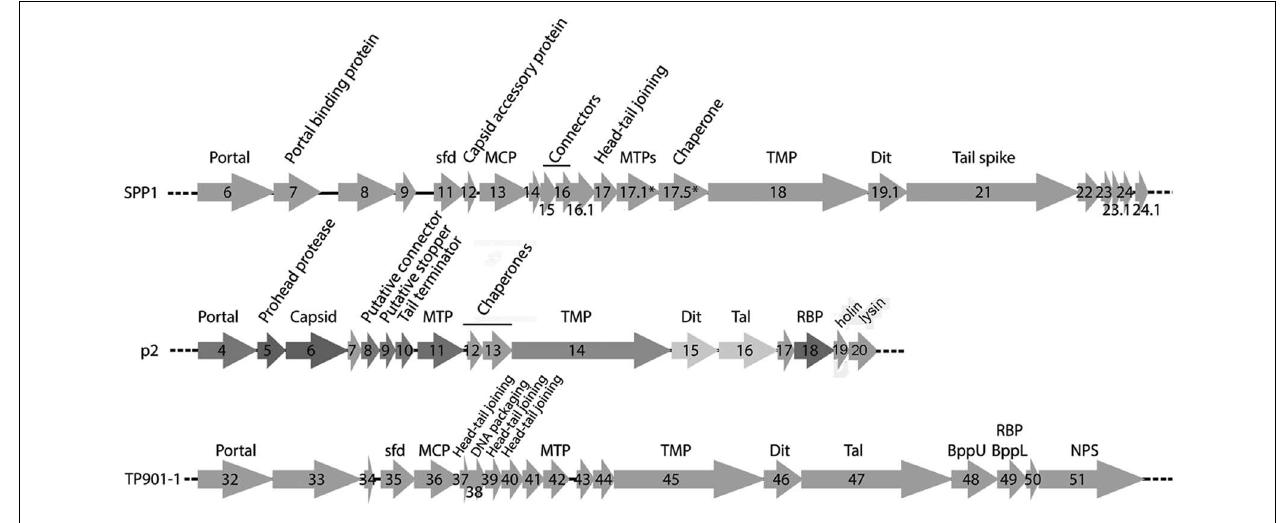
FIGURE 2 | Schematic representation and assignment of the structural gene module of phages SPP1, p2, and TP901-1. Genes coding for non-structural ORFs are in light gray. Sfd, scaffolding; MCP, major capsid protein; MTP, major tail protein; TMP, tail tape